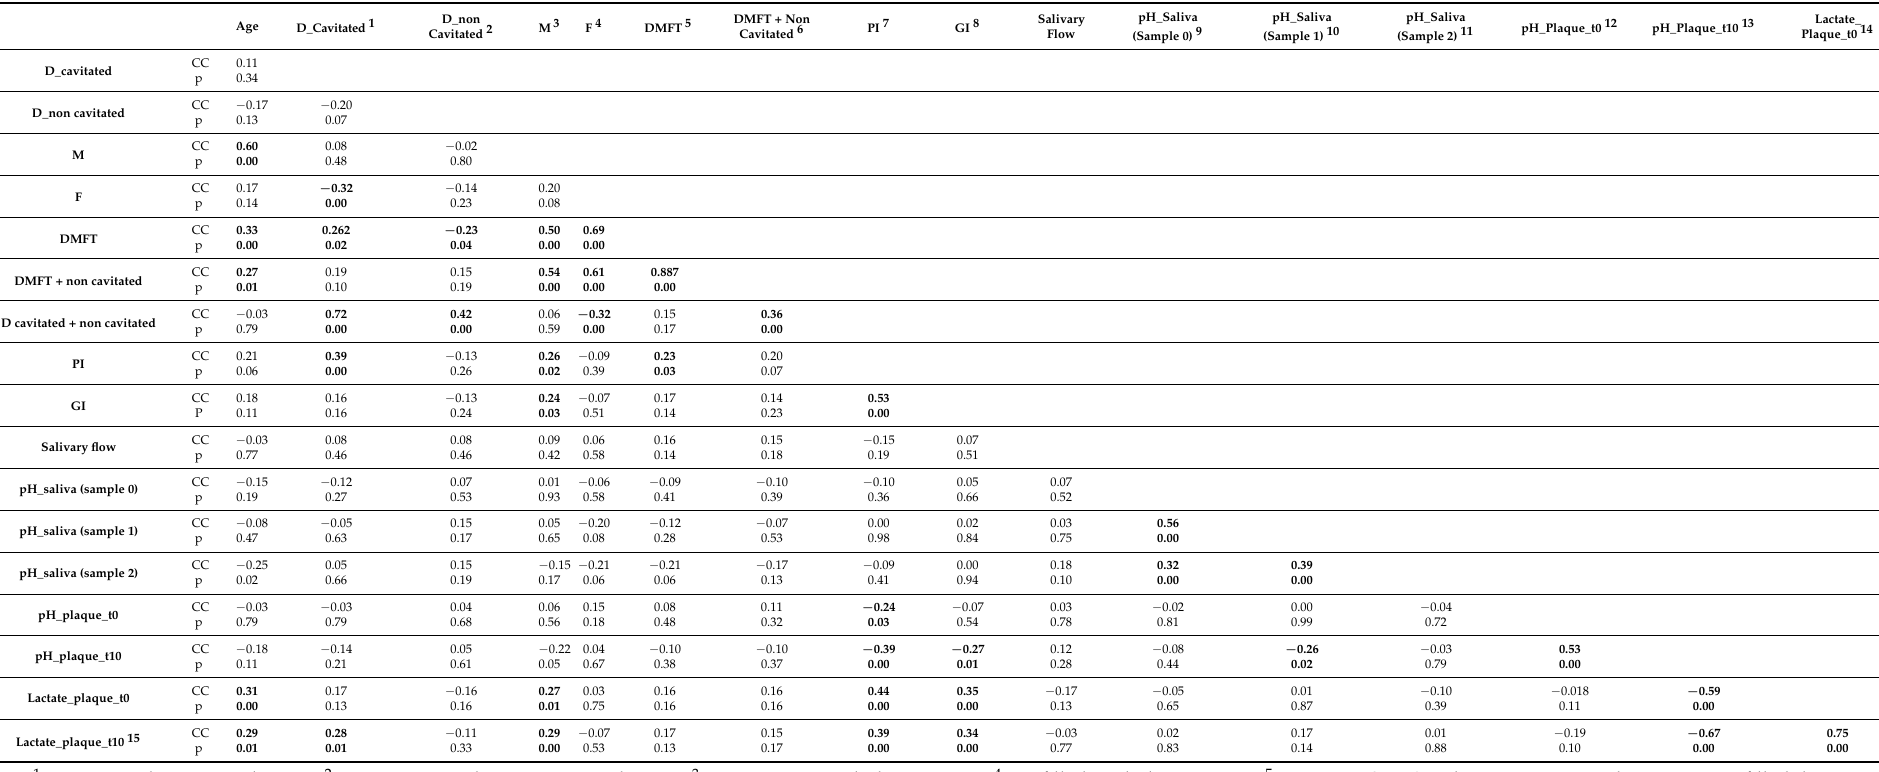
Table 1. Analysis of the correlations (Correlation Coefficients (CC) and p -values) between the quantitative variables assessed. Significant correlations are